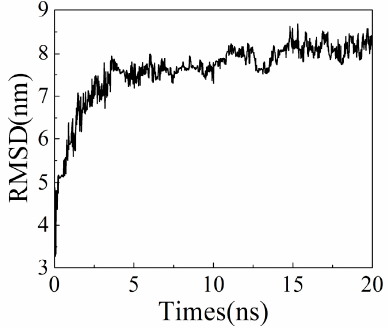
Figure 6. The root means square deviation (RMSD) of the structure vs. times.